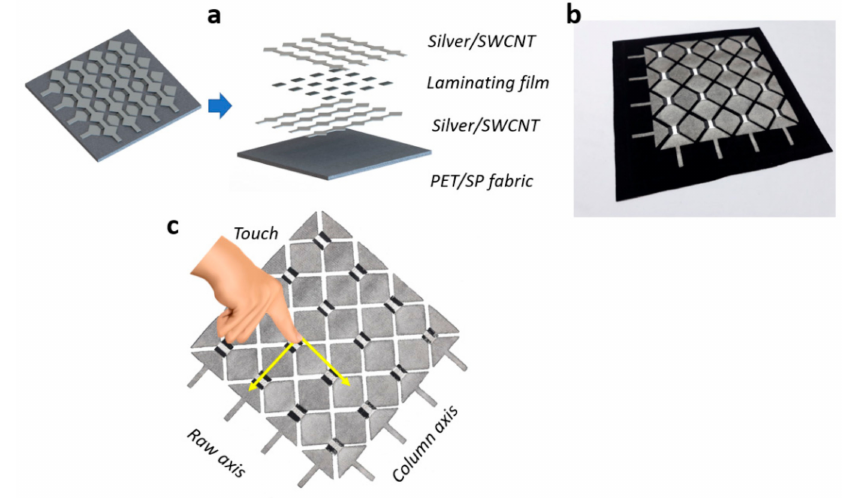
Figure 2. ( a ) Structure of the capacitive sensor layer, ( b ) real picture of the capacitive sensor layer, and ( c ) working principle of the capacitive sensor